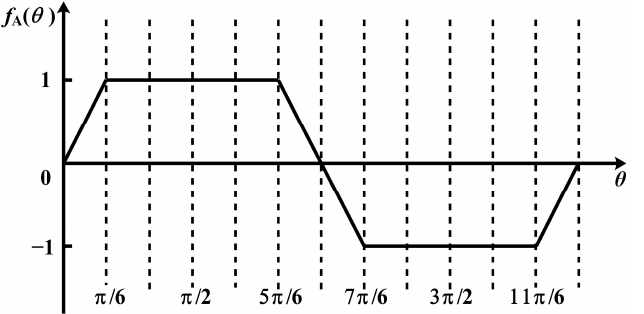
Figure 2. Back EMF waveform function of phase A.